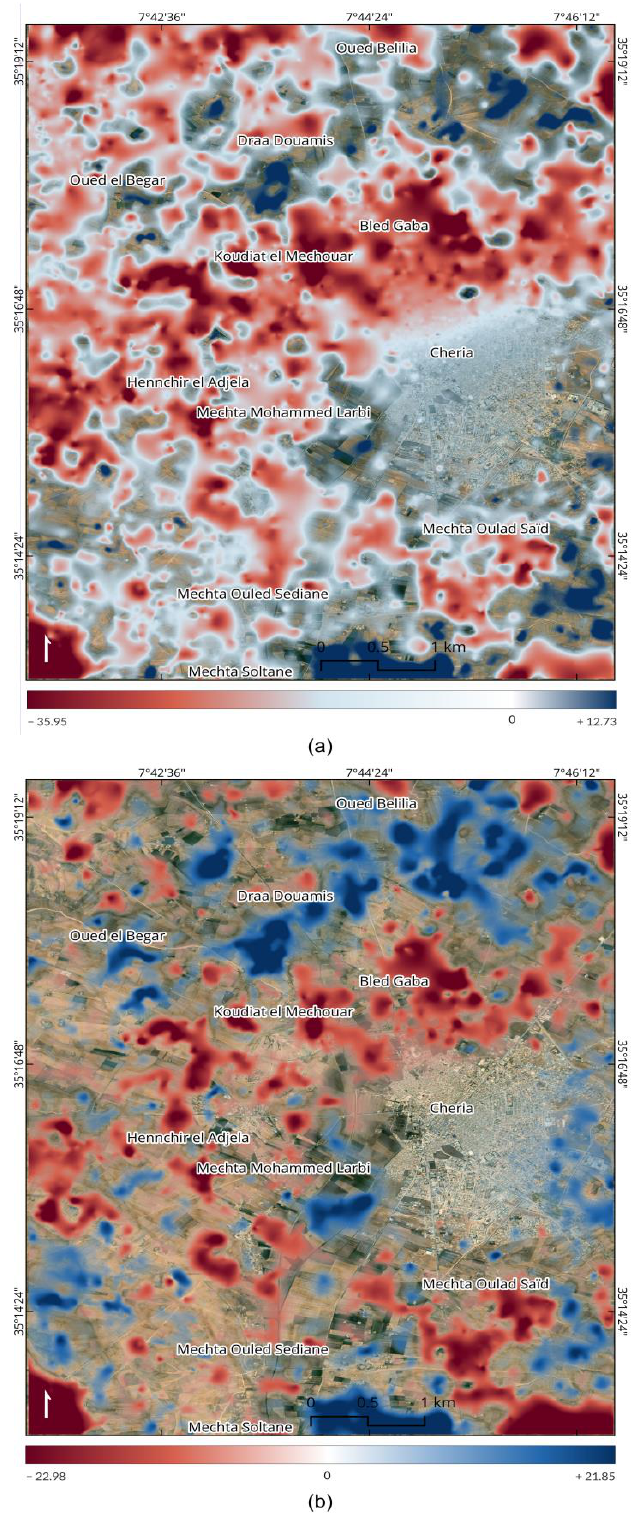
Figure 5. Vertical and horizontal mean velocity map of the study area showing ( a ) vertical mean velocity (up and down directions) and ( b ) horizontal mean velocity (east and west directions). (To enhance the visibility of positive and negative values, values close to 0 were rendered transparent.)